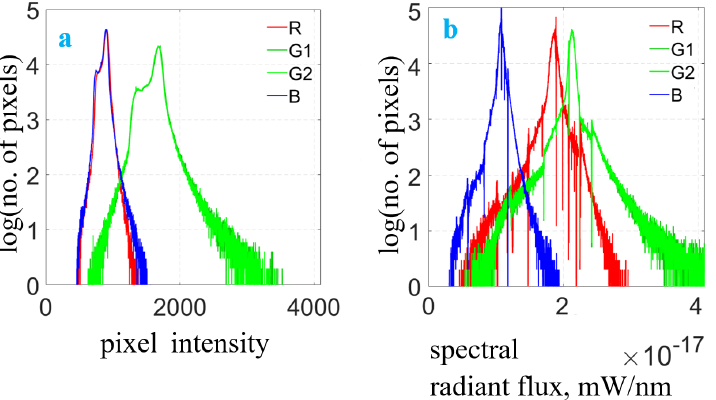
Figure 8. Red, green, and blue intensity histograms for raw format of the image in Figure 9. ( a ) Un- corrected raw image; ( b ) spectrally corrected raw